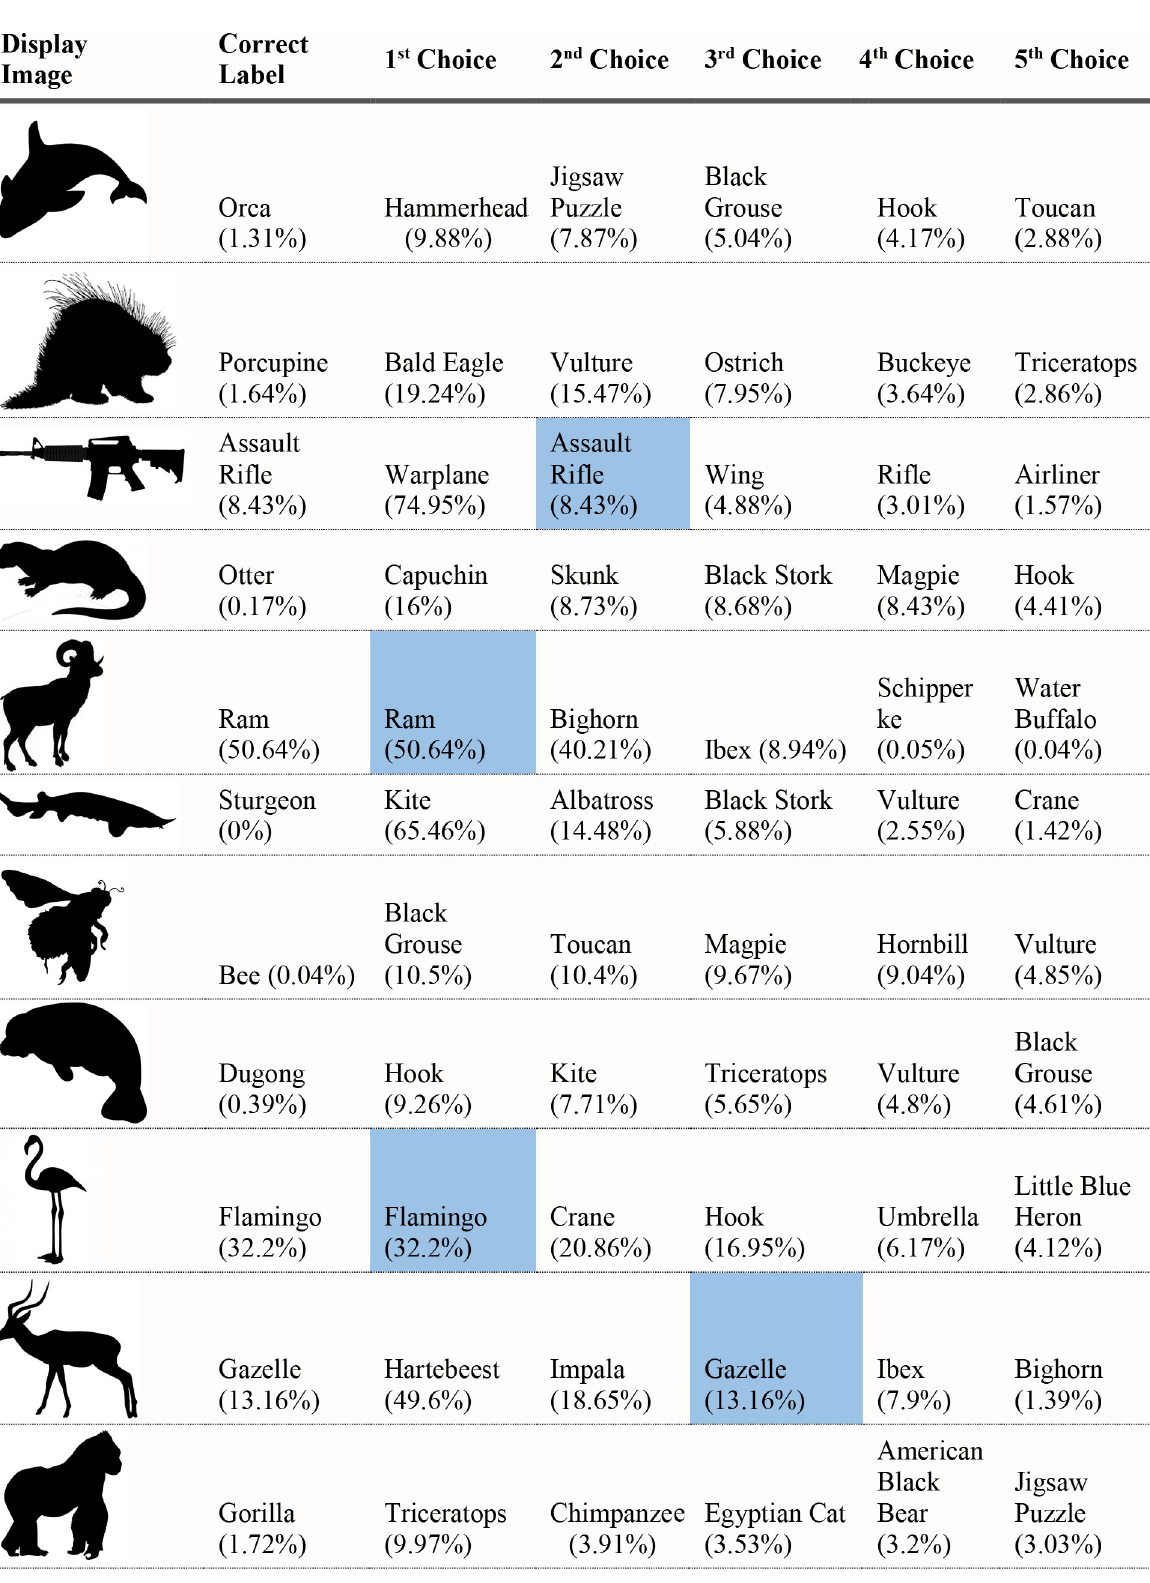
Fig 21. VGG-19 classifications for black object silhouettes Part 3.